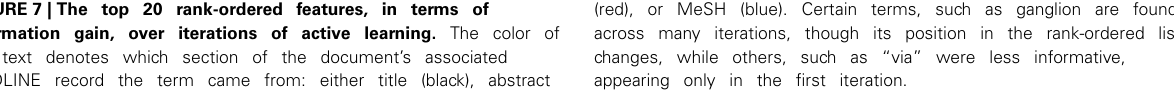
FIGURE 7 | The top 20 rank-ordered features, in terms of information gain, over iterations of active learning. The color of the text denotes which section of the document’s associated MEDLINE record the term came from: either title (black), abstract